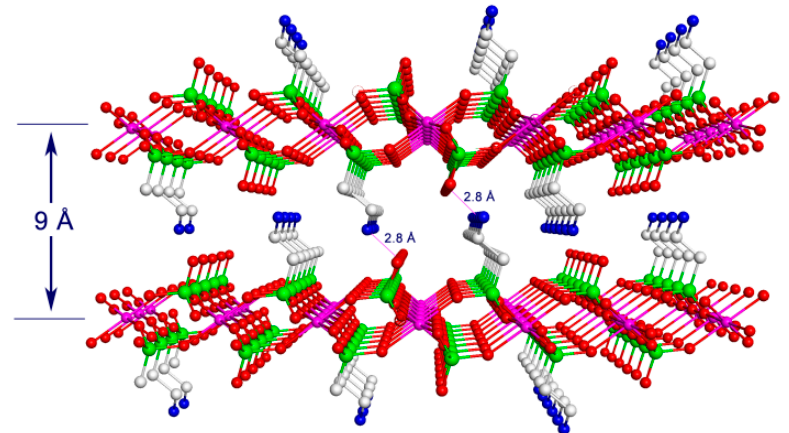
Figure 23. Schematic representation of a mixed α -Zr phosphate aminoethylphosphonate. Adapted with permission from reference [111]. Copyright 2019, Royal Society of Chemistry.